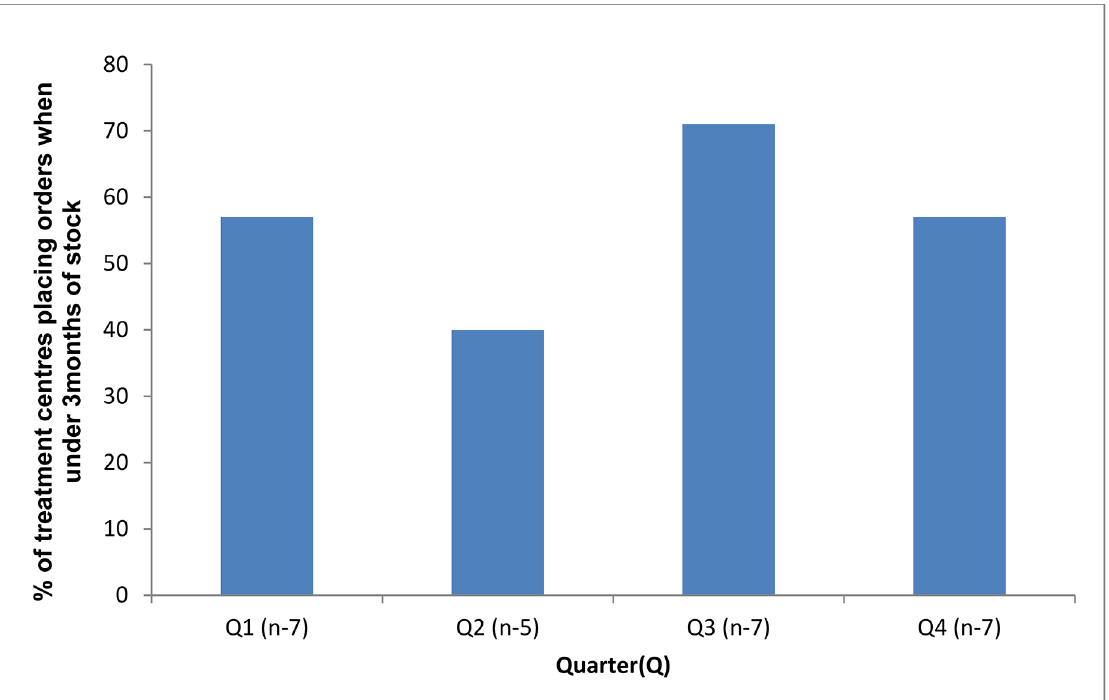
Fig 3. Proportion of treatment centres (n = 7) that placed an order for multi-drug resistant tuberculosis drugs when there was less than three months of stock (Target = 0%).